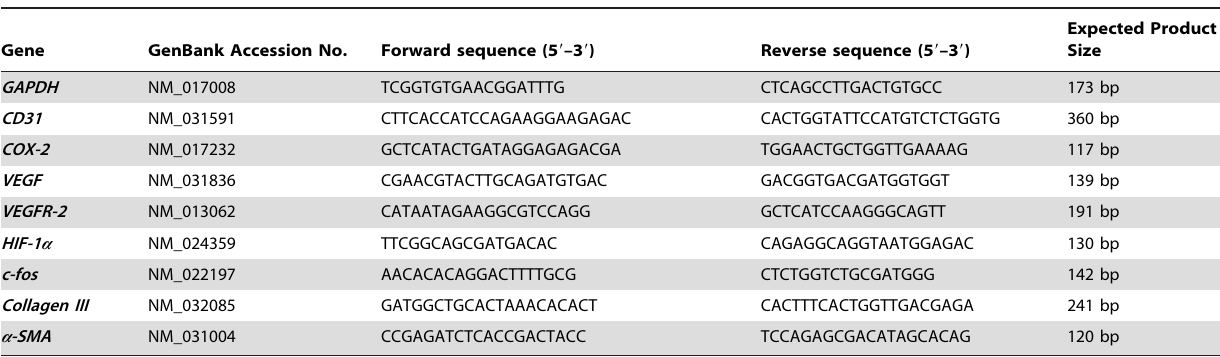
Table 1. List of primers for qRT-PCR.